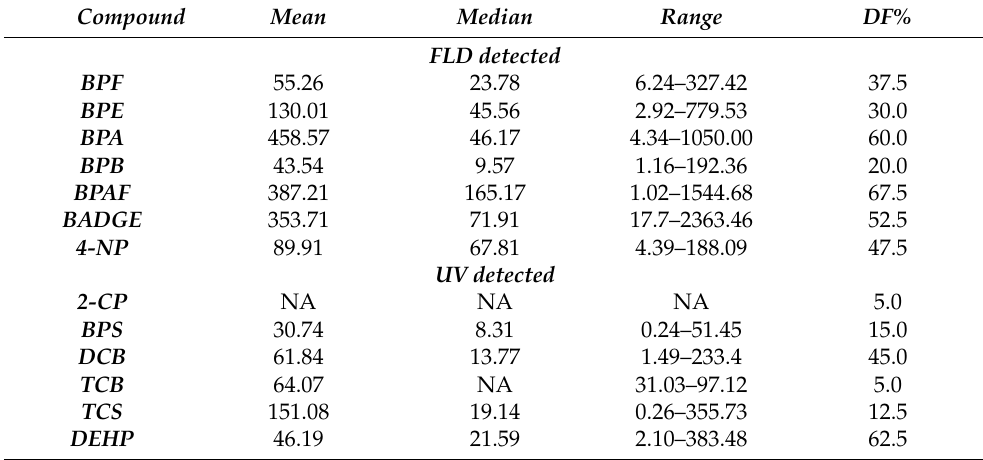
Table 3. Mean, median, range of concentration, and detection frequency (DF%) of the investigated chemicals. Values are expressed as ng L − 1 for FLD detected chemicals and as µ g L − 1 for UV detected chemicals. NA = not